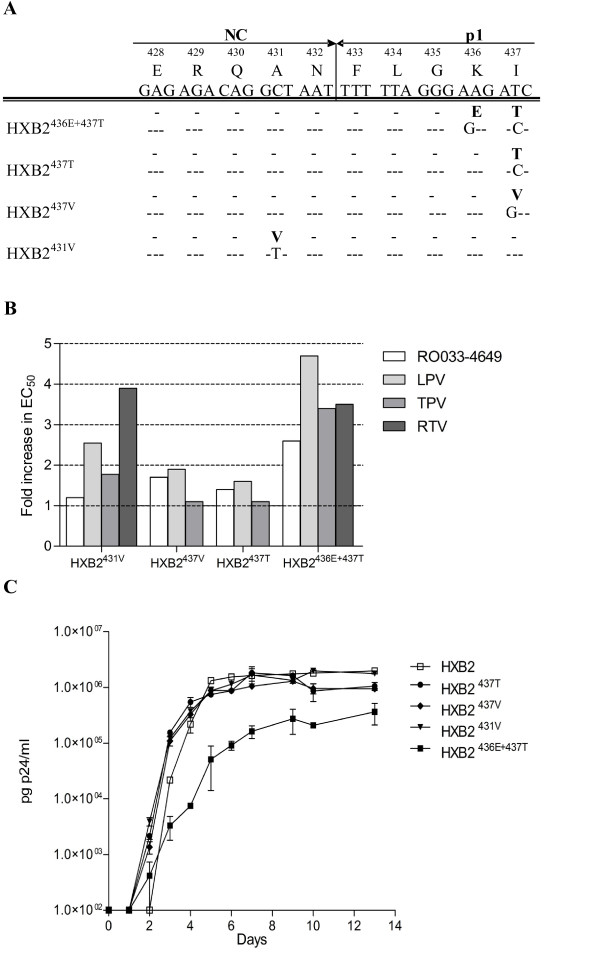
Analysis of PI susceptibility and viral replicative capacity of NC/p1 cleavage site mutants. (A) Sequences of the NC/p1 cleavage site mutants used in this study. Nucleotide changes and amino acid changes (bold) as compared to the wild-type virus HXB2 are indicated. (B) Analysis of drug susceptibility of the NC/p1 cleavage site mutants to RO033-4649, lopinavir (LPV), tipranavir (TPV) and ritonavir (RTV). Indicated are the fold changes in EC50 compared to wild-type. (C) Viral replication curves of the different NC/p1 cleavage site mutants (HXB2436E+437T, HXB2437T, HXB2437V and HXB2431V) as compared to the wild-type HXB2. Error bars indicate the standard error of the mean.